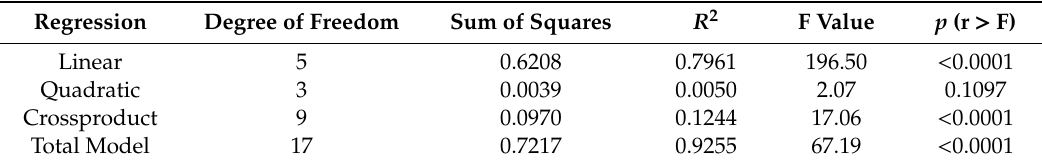
Table 7. The estimate inspection of final DF 60 model parameters.